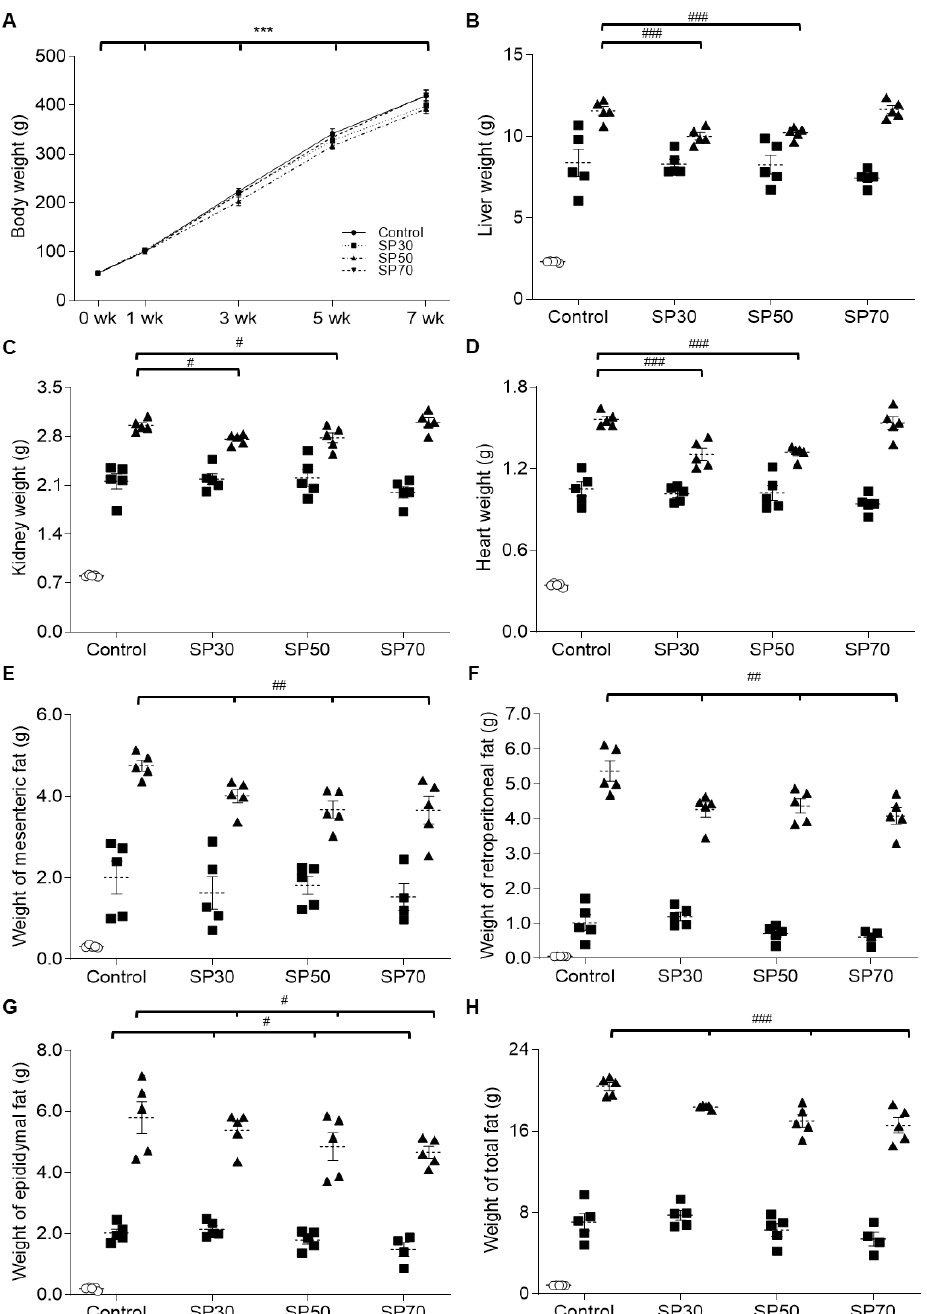
Figure 1. E ff ect of spirulina on the weight of body, organs, and fat tissues. Weights of ( A ) body, ( B ) liver (g / 100 g BW), ( C ) kidney (g / 100 g BW), ( D ) heart (g / 100 g BW), ( E ) mesenteric fat (g / 100 g BW), ( F ) retroperitoneal fat (g / 100 g BW), ( G ) epididymal fat (g / 100 g BW), and ( H ) total fat (g / 100 g BW) were measured in growing male rats over the 7-week course of the study. Data are mean ± SEM values. Significant di ff erences were determined using t -tests or one-way ANOVA with post hoc Duncan’s multiple-range test comparisons. *** p < 0.001 between weeks within a group and # p < 0.05, ## p < 0.01, or ### p < 0.001 between groups in the same week. Control: AIN 93G diet; SP30: 30% of protein source replaced with spirulina; SP50: 50% of protein source replaced with spirulina; SP70: 70% of protein source replaced with spirulina. The week of the treatment is represented by O: 0 weeks; (cid:4) : 3 weeks; (cid:78) : 7 weeks in each